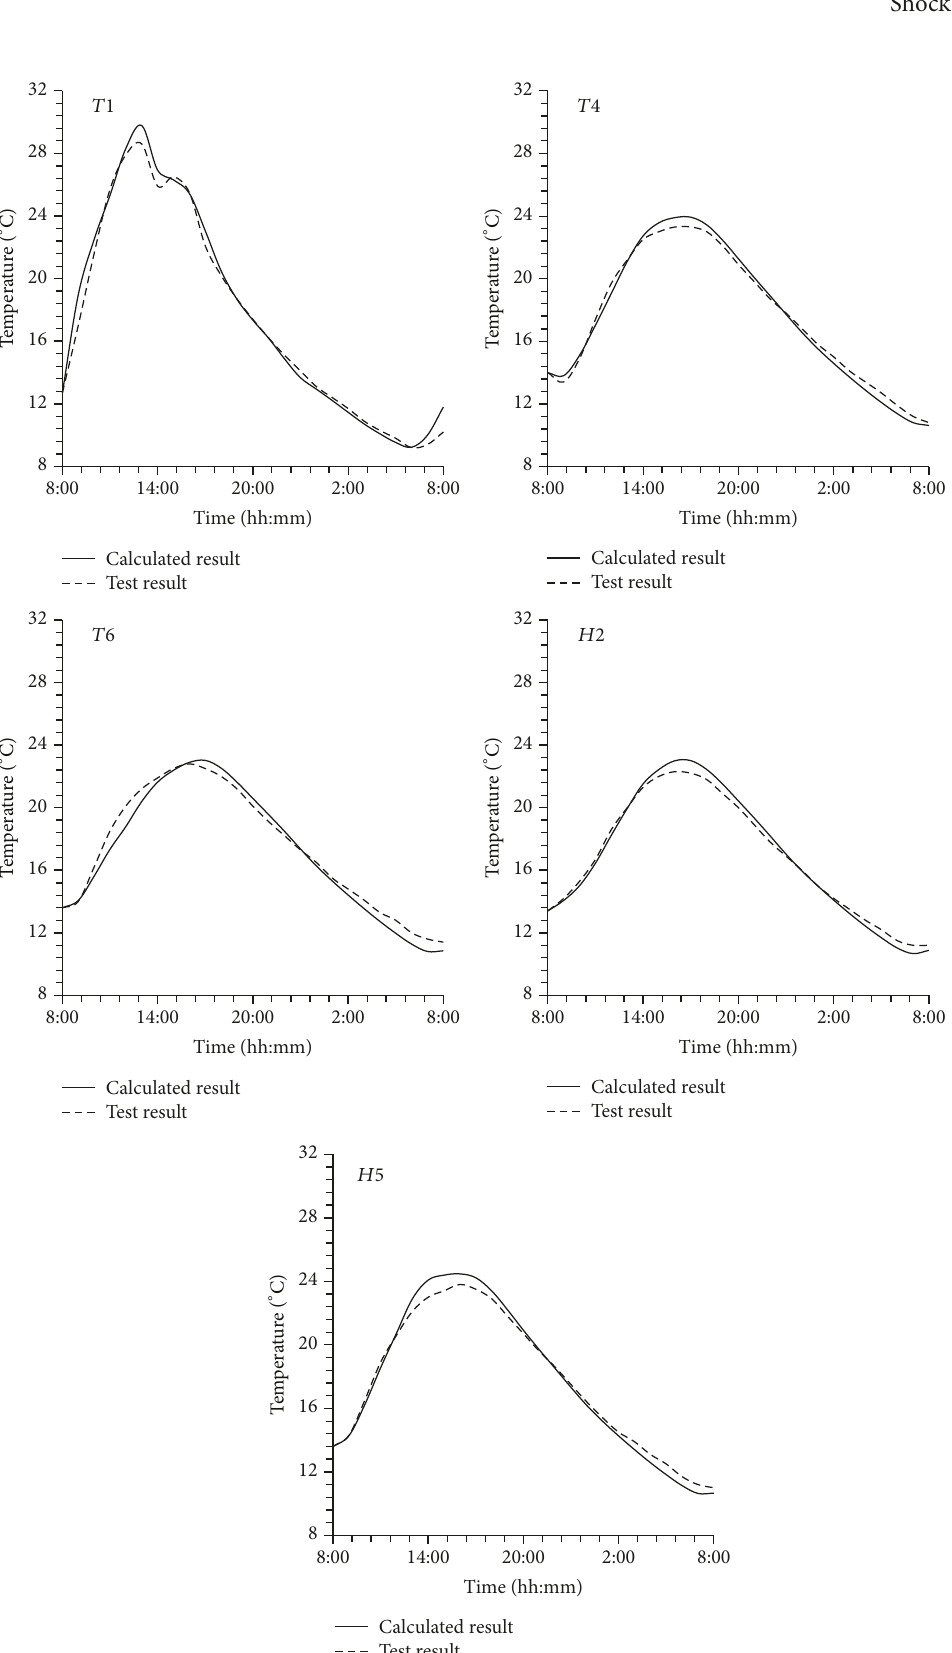
Figure 10: Comparison of temperature data in a 24-hour period: calculated and test